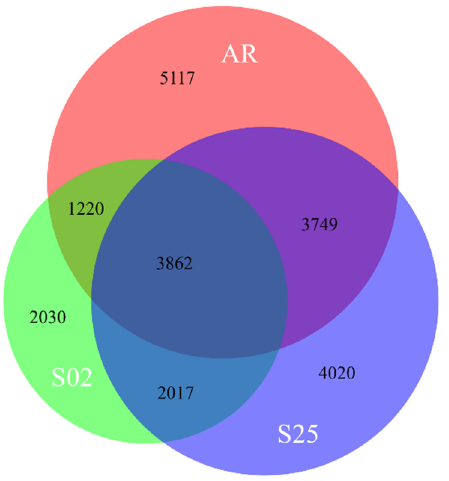
Figure 5. A Venn diagram that shows the number of barley genes that were differentially ex- pressed in roots during the plant–bacteria interaction assay for all three strains in Nutrient Broth. A total of 22,015 genes were differentially expressed. AR: Novel E. gerundensis strain; S02/S25: Novel Paenibacillus sp.